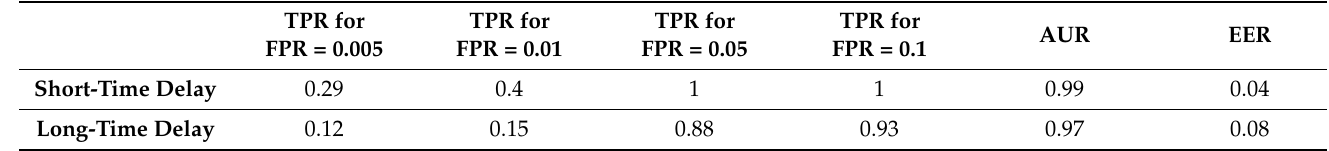
Table 2. Performance comparison for testing gestures executed with different delays from the training